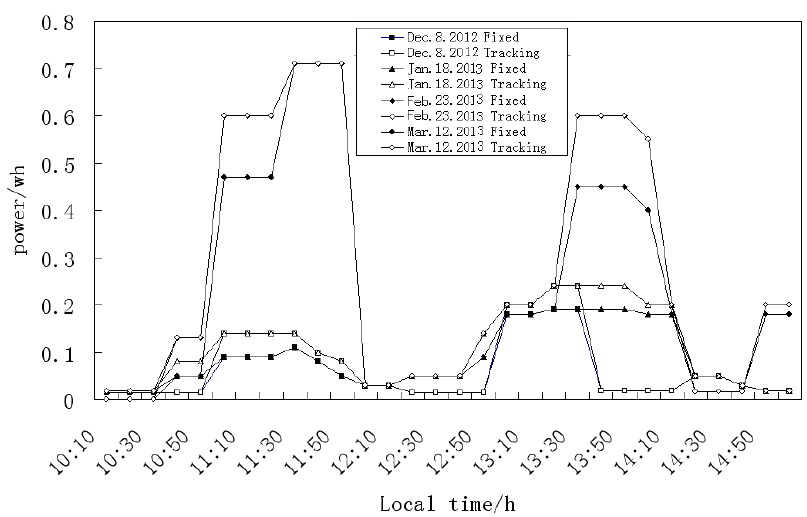
Figure 5. Power generated (Wh) over time (plotted in 10-min increments) on days that were intermittently sunny and cloudy.